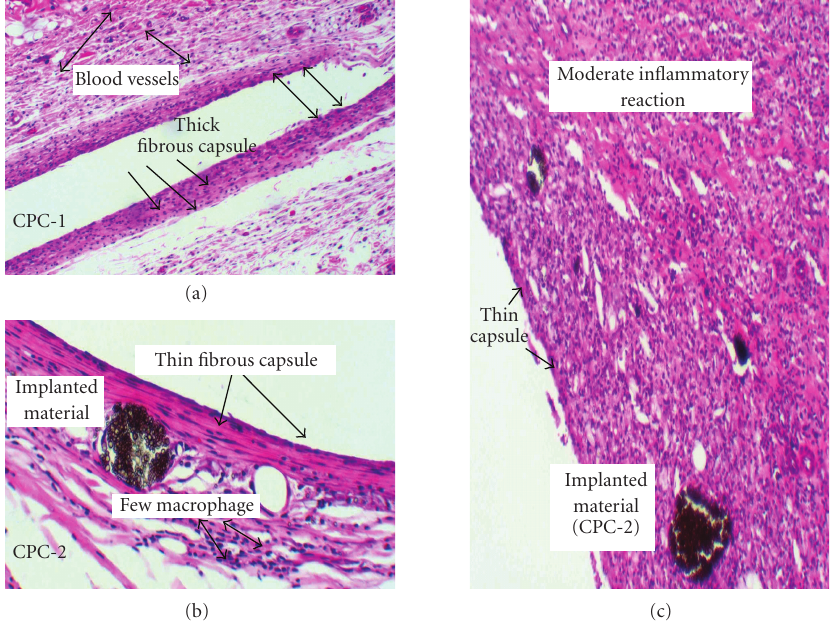
Figure 6: Tissue reactivity to implanted materials at 30 days. (a) Note the thick fibrous capsule (arrows) and the small dilated blood vessels in response to the implanted material (CPC-1) (arrows). (b) CPC-2 at 30 days demonstrates a thin fibrous capsule (arrows) and few macrophages adjacent to the implanted material. (c) Area showing a moderate inflammatory reaction and a thin fibrous capsule as seen in CPC-2 and HA implanted materials (CPC-2 shown). H&E